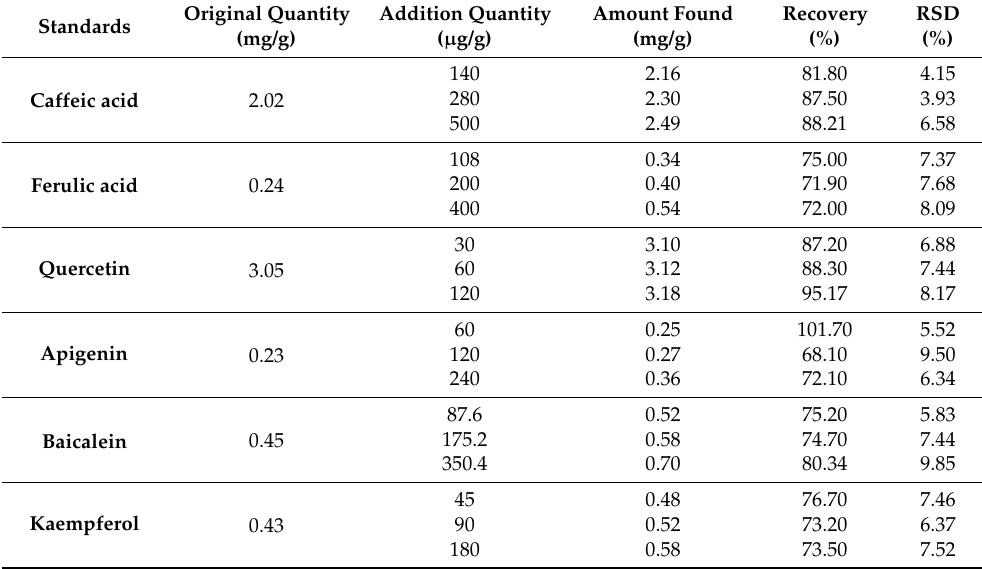
Table 4. Recovery of the six tested compounds in